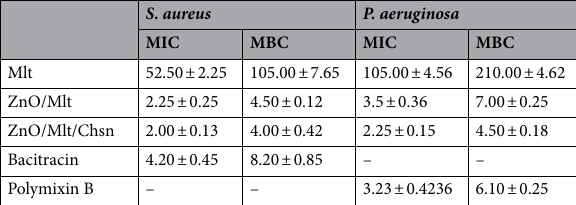
Table 1. Bacteriostatic and bactericide activities of the prepared nanocomposites (µg/mL).